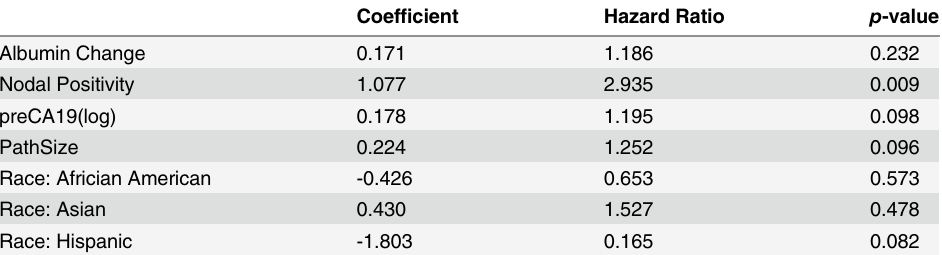
Table 2. Parameter Estimates from Multivariate Cox Regression Model for Disease-free Survival.